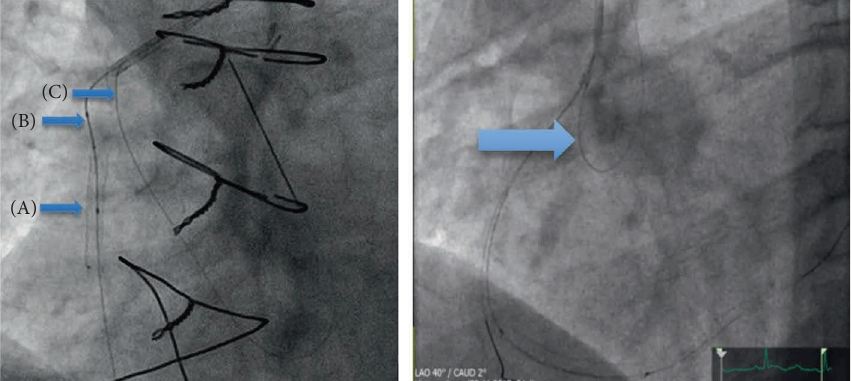
Figure 2: (a) SVG of RCA with stenosis located in proximal shaft: (b) modifed foating wire technique. (a) SVG-stenosis located in proximal shaft, SExS (Xposition S ® 3.0–3.5 ∗ 27 mm) implantation (A), sheath retrieval (B) with support of coronary wire (C). (b) Proximal SVG- RCA stenosis with implantation of Xposition S 3.0–3.5 ∗ 27mm, sheath retrieval with insertion of an additional wire through the guiding catheter foating free in the ascending aorta � > prevention of deep intubation with possible subsequent distal wire perforation. RCA � right coronary artery; SVG � saphenous vein graft; SExS: self-expanding drug eluting